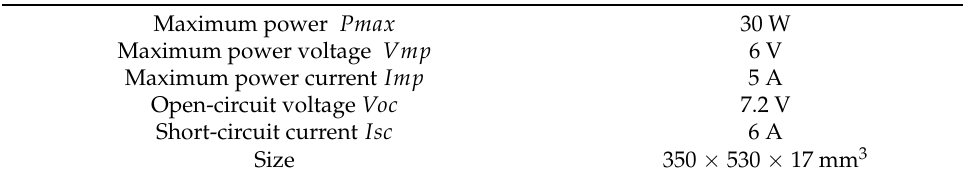
Table 4. Technical characteristics of the solar panel.